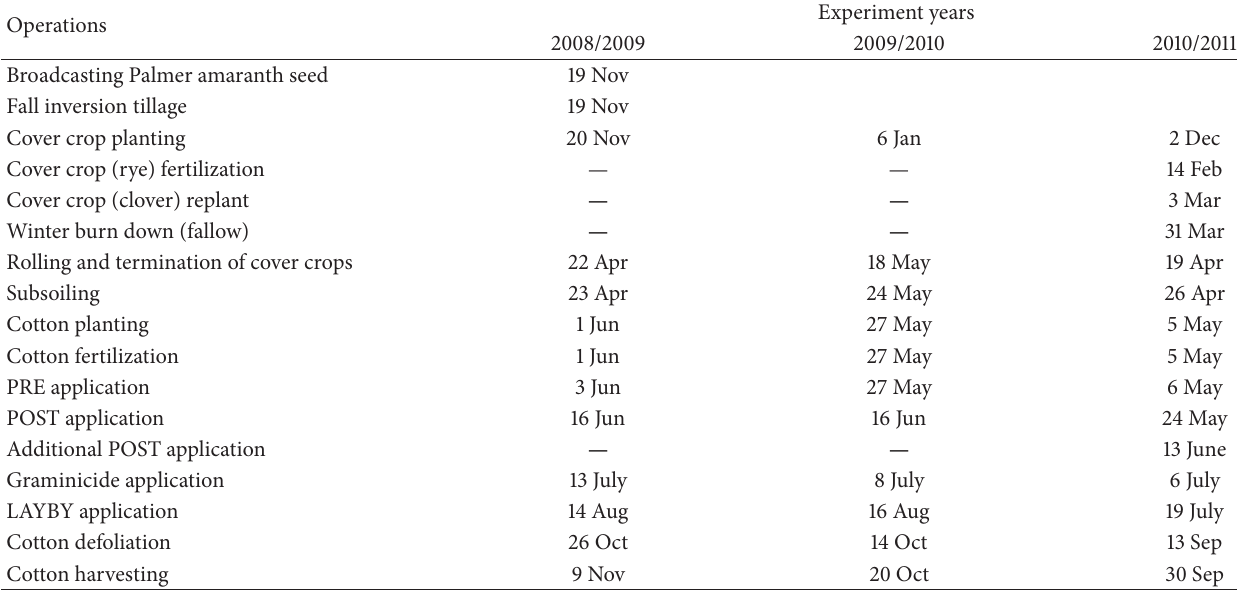
Table 1: Schedule of operations a .